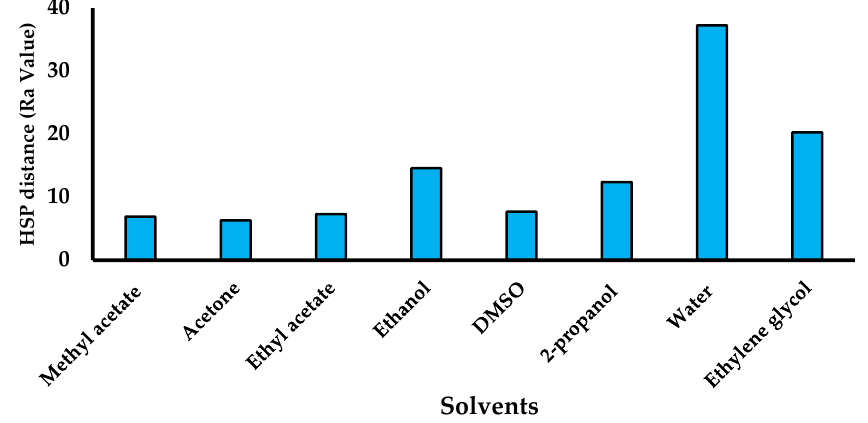
Figure 1. HSB parameters’ study with Ra value for the selected solvents.